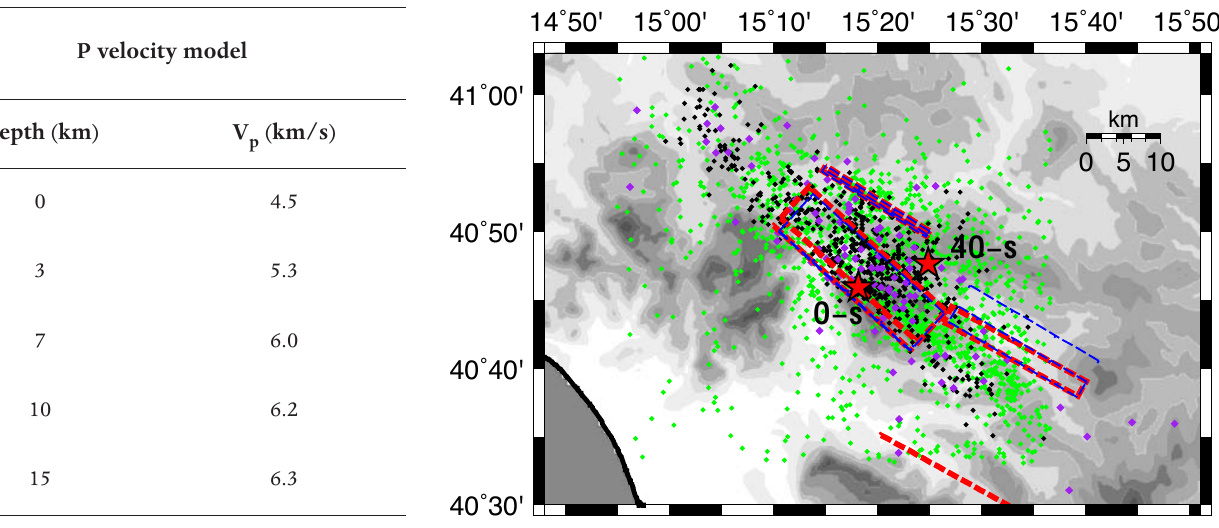
Table 2 (left). The 1D velocity model. Figure 2 (right). Map of the study area showing the spatial distribution of the earthquakes that occurred after the November 23, 1980 event. Black diamonds, epicenters of the earthquakes that occurred in the period of December 1 to 15, 1980. Purple diamonds, epicenters of the earthquakes that occurred in the period of November 23 to 30 and December 16 to 31, 1980. Green diamonds, epicenters of the earthquakes that occurred in the period of 1982 to 2008 (from the INGV catalog: http://csi.rm.ingv.it). Stars, locations of the main rupture, as reported in Table 1; red and blue rectangles and dashed segments, surface projections and traces of the fault planes of Amoruso et al. [2005a], types A and B, respectively.